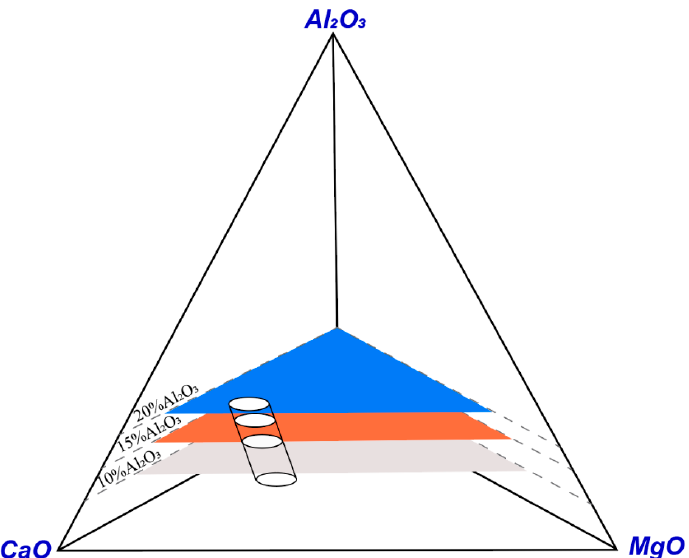
Figure 3. Representation of the pseudo-ternary phase diagrams CaO-MgO-SiO 2 with constant Al 2 O 3 concentrations of 10, 15 and 20% [7].